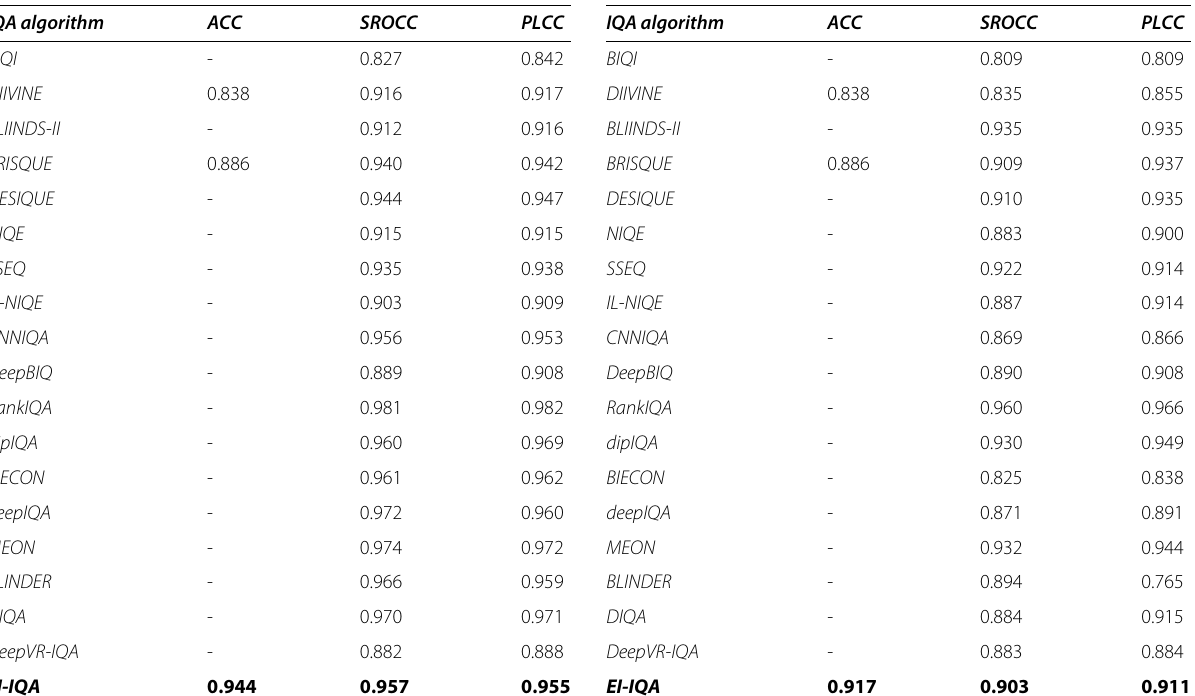
Table 5 Test results on LIVE database